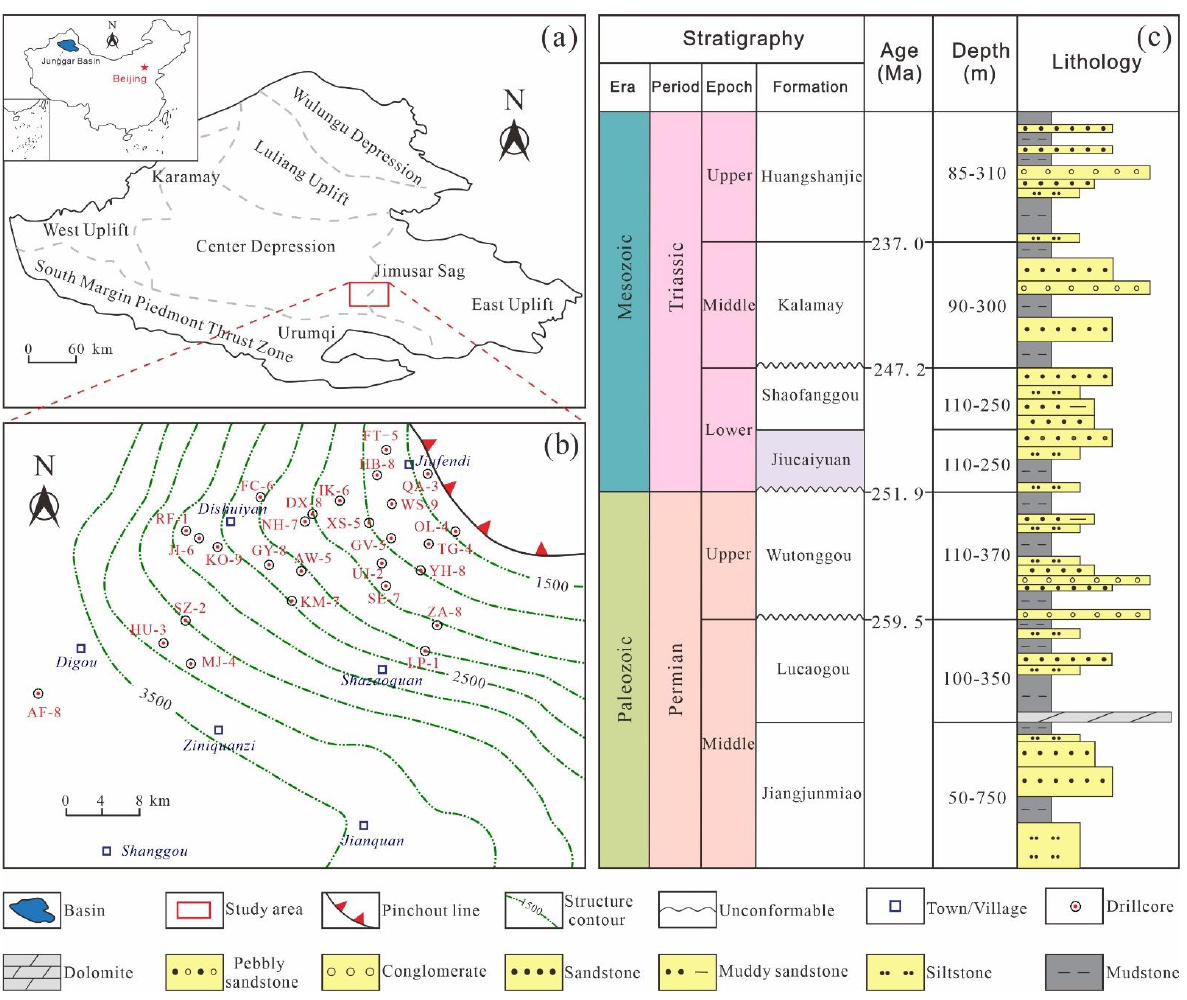
Figure 1. Present locations and composite stratigraphic columnar section of the Jiucaiyuan Formation in the Beisantai Uplift, eastern Junggar Basin. ( a ) Regional index map (after Zhang [27]). ( b ) Structural trend of the Jiucaiyuan Formation and some drilling positions (after He et al. [28]). ( c ) Stratigraphic column of the Jiucaiyuan Formation in the Beisantai Uplift, eastern Junggar Basin (after Zhang [27]; Cohen et al. [29]).